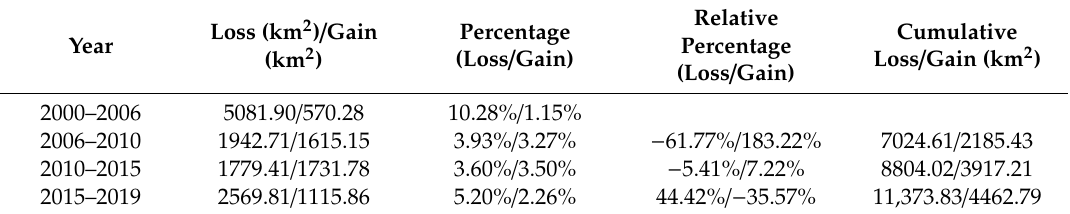
Table 3. Forest loss and gain from 2000 to 2019.